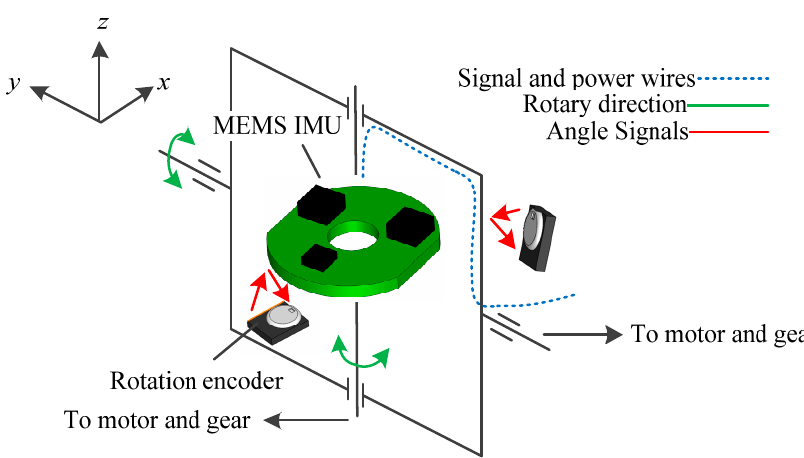
Figure 2. Block diagram of the